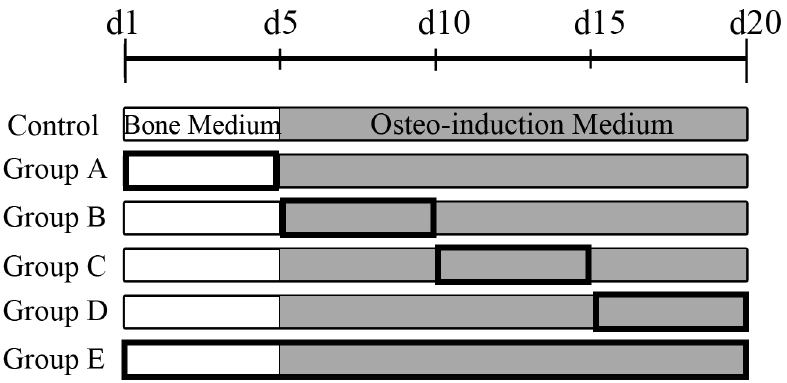
Figure 1. A schematic graph of Aln treatment strategies. All undifferentiated hBMSCs were seeded in 24-well plates and cultured for 5 days with bone medium (BM). Then, osteogenesis was induced using osteo-induction medium (OIM) for 15 days. The 5-day intervals of Aln treatments (indicated by bold frames) were performed during the first 5 days of culture (group A), day 6–10 (group B), 11–15 (group C), 16–20 (group D) or through entire experiment (group E). The control group was cultured with BM and then OIM without Aln